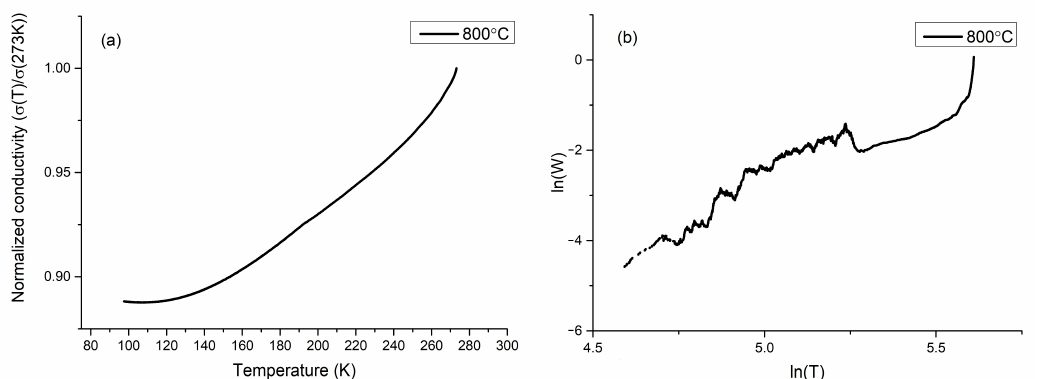
Figure 7. ( a ) Normalized conductivity of sample sintered at 800 °C ( b ) reduced activation energy plot of sample sintered at 800 °C.